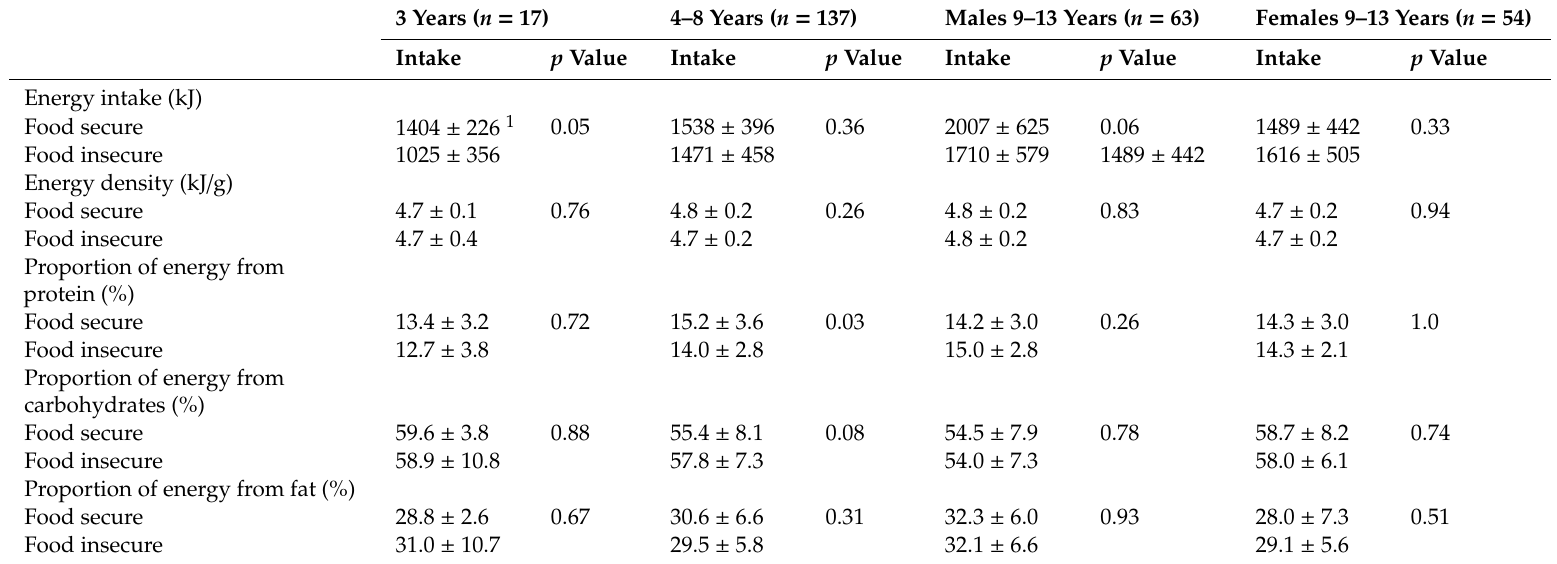
Table 4. Children’s mean energy density and macronutrient composition from 24-hr recall average in relation to household food security status